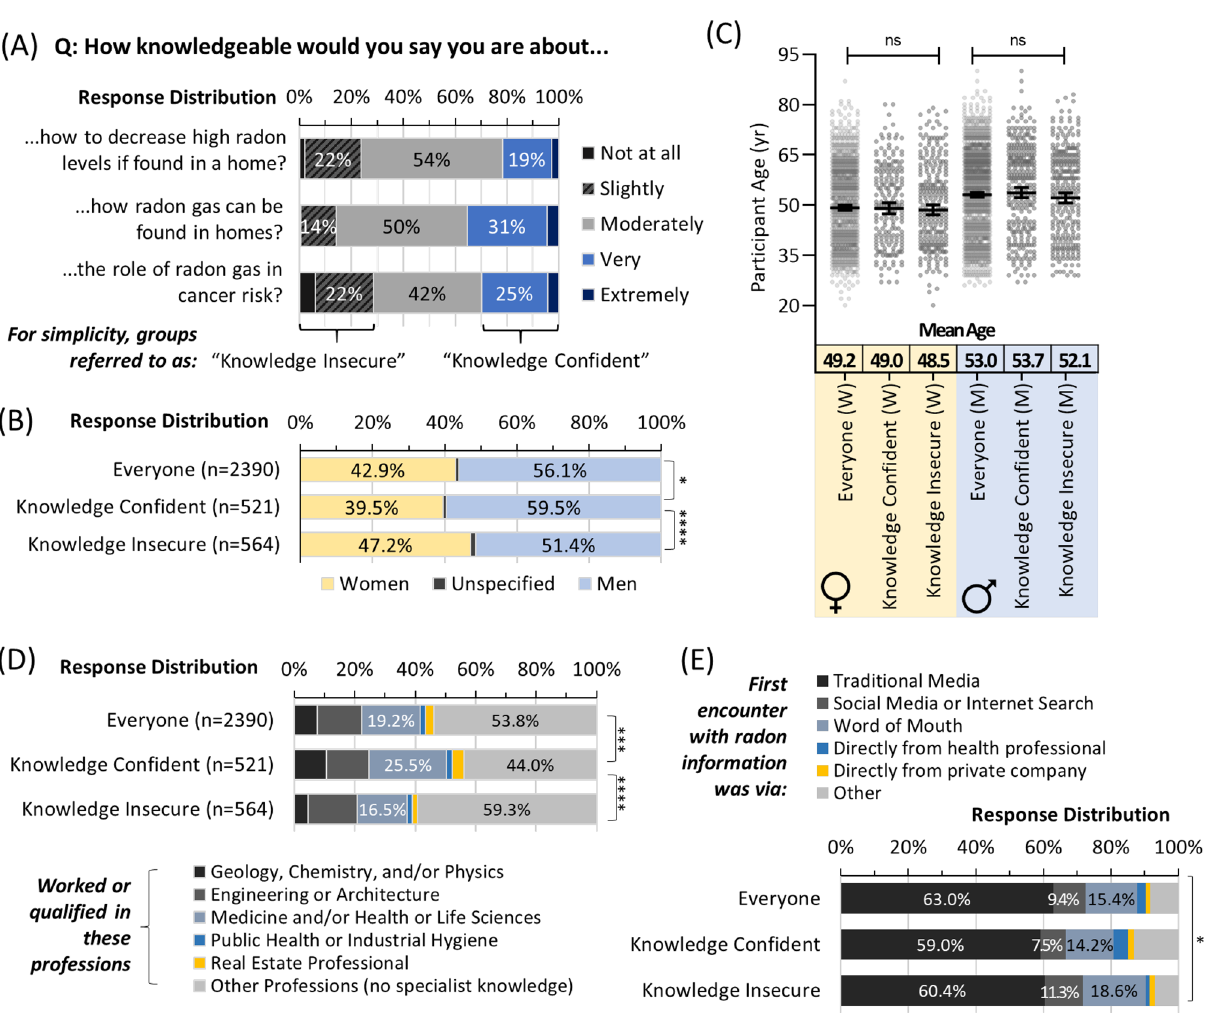
Figure 2. Radon knowledge perceptions differ by profession and sex but not age. Panel ( A ) Overall distribution of responses to indicated questions on self-perceptions of radon knowledge. Panel ( B ) Self-perceptions of radon knowledge as a function of sex. Panel ( C ) Self-perceptions of radon knowledge as a function of sex and age. Mean Age refers to a geometric mean ± CI 95% . Panel ( D ) Self-perceptions of radon knowledge as a function of status (worked or qualified) in professions with or without the potential for a specialist on radon. Panel ( E ) Self-perceptions of radon knowledge as a function of the first encounter with radon awareness information. Statistical comparisons are Mann–Whitney pairwise nonparametric t-tests of comparisons for scatter plot data or 1-way ANOVA for all other data. **** = p < 0.0001; *** = p < 0.001; * = p < 0.05; ns = p > 0.05. Figures were prepared using Excel and GraphPad Prism 9.1.1 (225) (www. graph pad.